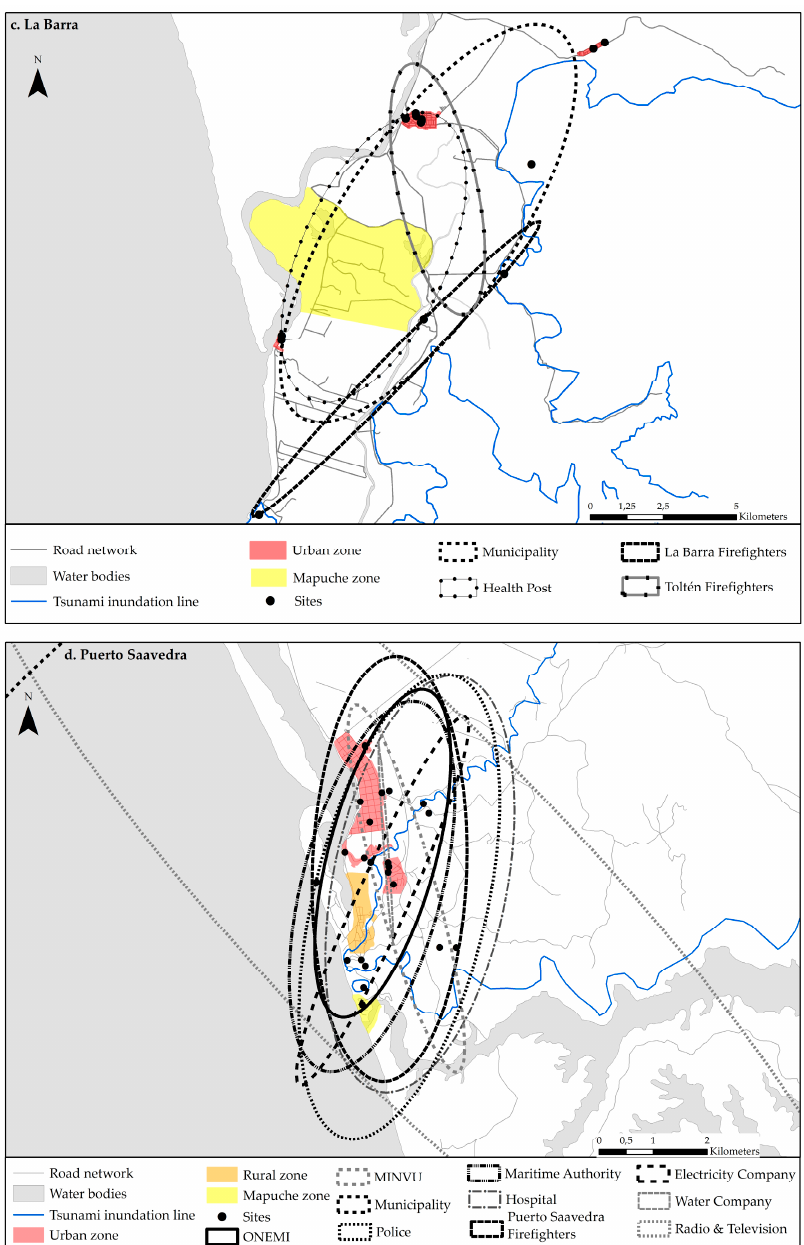
Figure 5. ( a ) Directional Distribution Map: Mehuín; ( b ) Directional Distribution Map: Queule; ( c ) Directional Distribution Map: La Barra; ( d ) Directional Distribution Map: Puerto Saavedra. Table 2. Area of influence of the standard deviation ellipses.